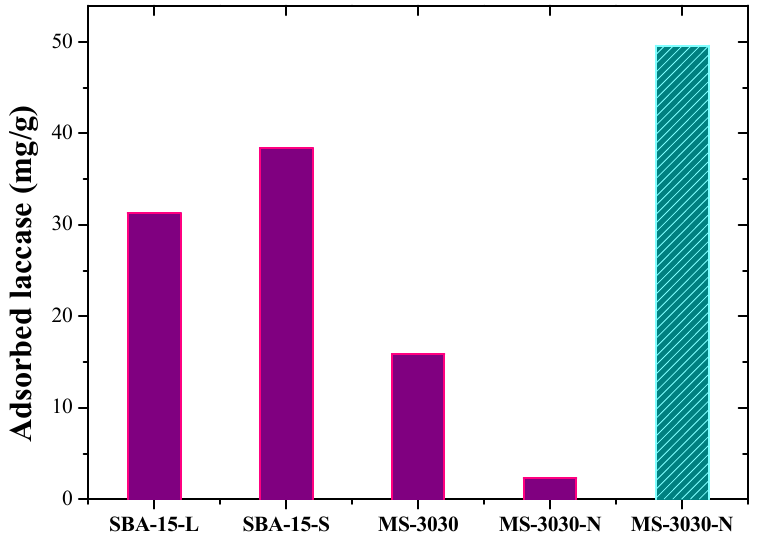
Figure 7. Adsorption capacity of different supports. Solid bars: immobilization at pH 3.5. Dashed bar: immobilization at pH 5.5.